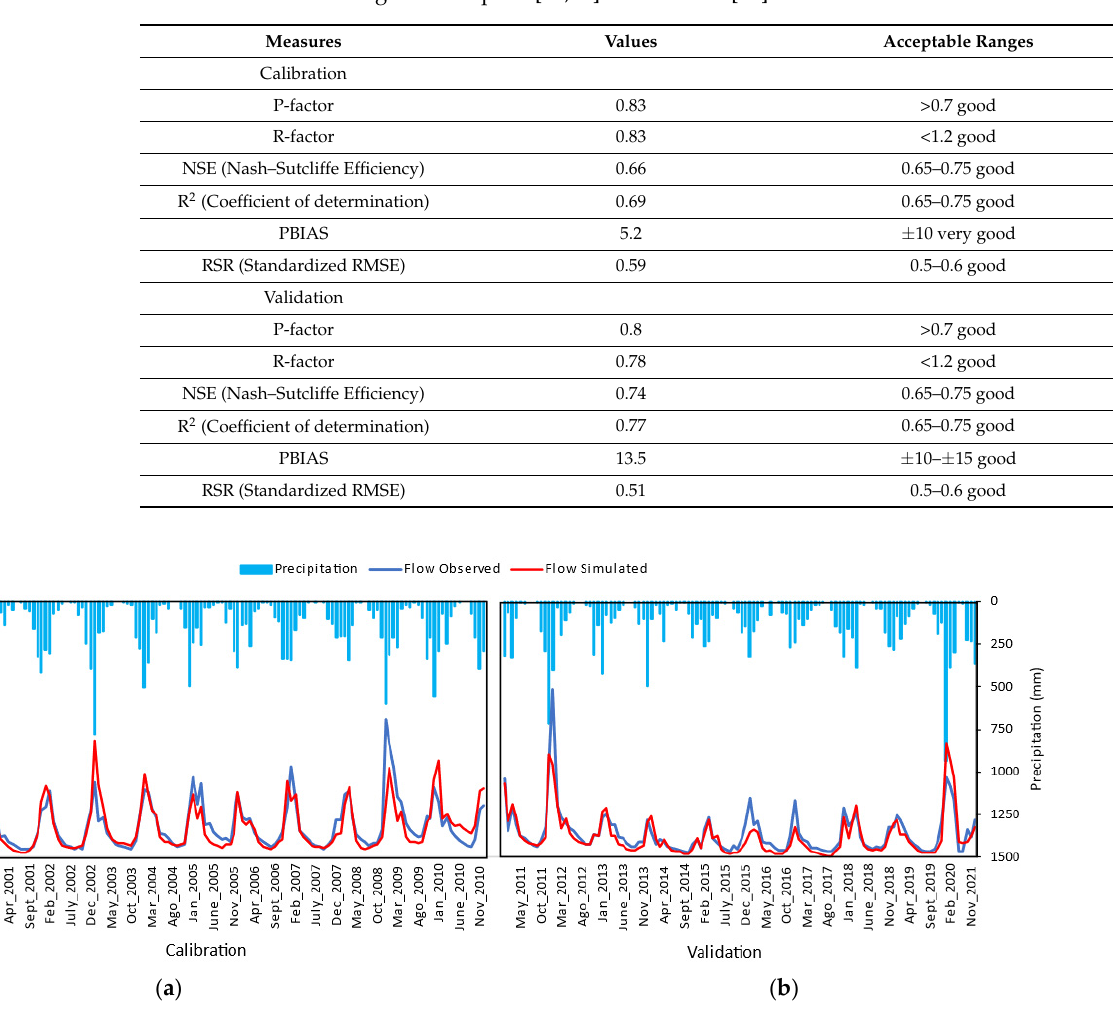
Figure 8. Precipitation and monthly fl ow observed and simulated during ( a ) calibration (between 2000 and 2010) and ( b ) validation (between 2011 and 2021) in the Paraopeba River Basin, station Alberto Flores.